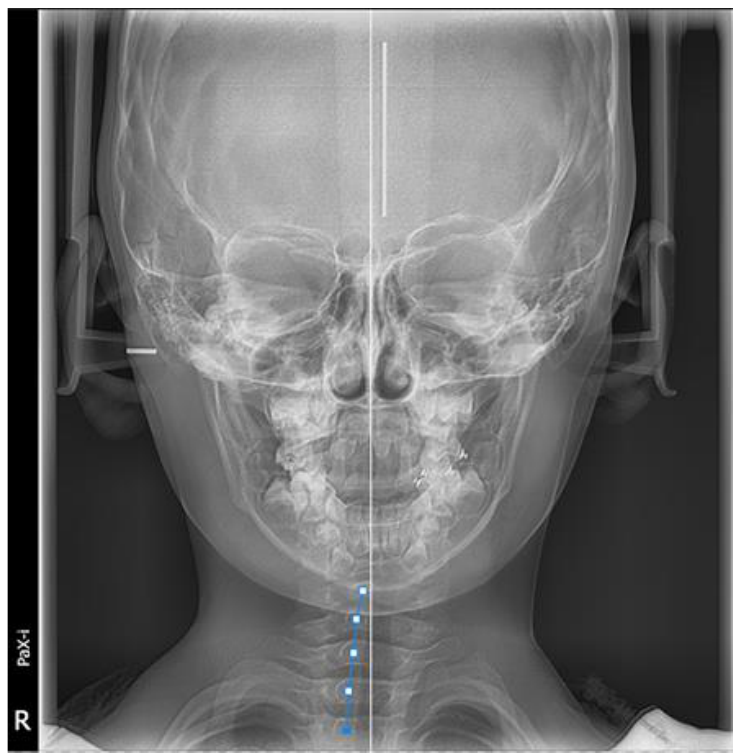
Figure 14. Intraoperative posteroanterior cephalograms.